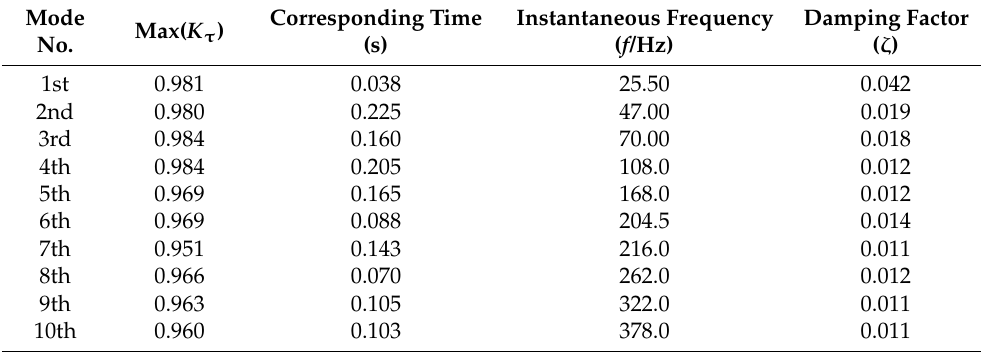
Figure 7. First mode in the vibration response signal of the wooden utility pole labeled as 57704: ( a ) the vibration response of the first mode in the time domain, ( b ) the frequency spectrum of the first mode, and ( c ) the results of Laplace wavelet correlation filtering of the first mode. Table 5. Instantaneous frequencies and damping factors of decomposed signals of the first 20 modes of the wooden utility pole labeled as